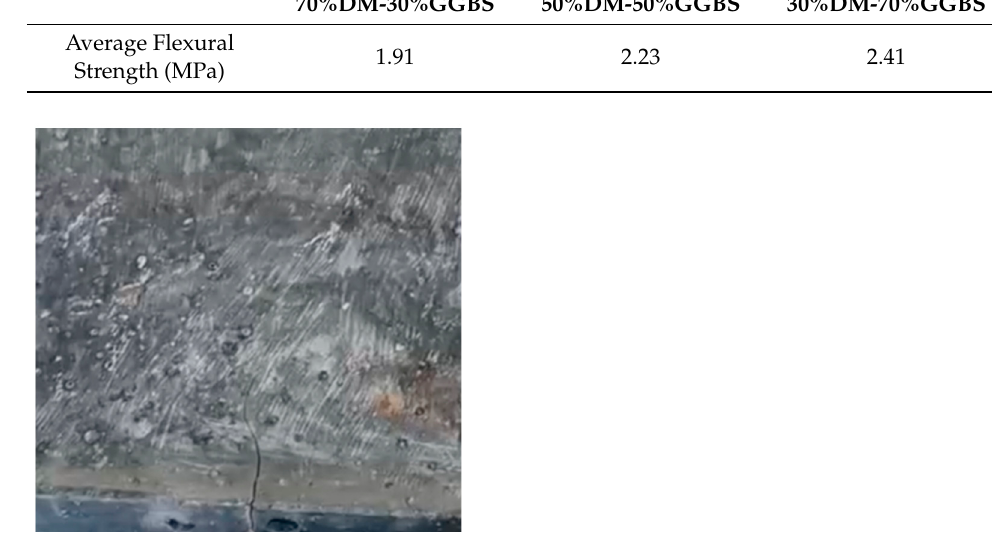
Figure 9. 70%DM ‐ 30%GGBS Pavement tile specimen image. Excessive cracking was observed on the tile surfaces before any experimental loading was applied on the specimens. Numerous hairline cracks were visible on the top surface of each specimen, while at least one thicker crack had formed perpendicular to the casting form edge (at least on one side) on all specimens. The multiple hairline cracks are identi ‐ fied as autogenous shrinkage cracking and the wider cracks that formed perpendicular to mold edges are possibly caused by drying shrinkage, since they were always perpendic ‐ ular to the edges and their width varied between 0.30 and 0.72 mm.